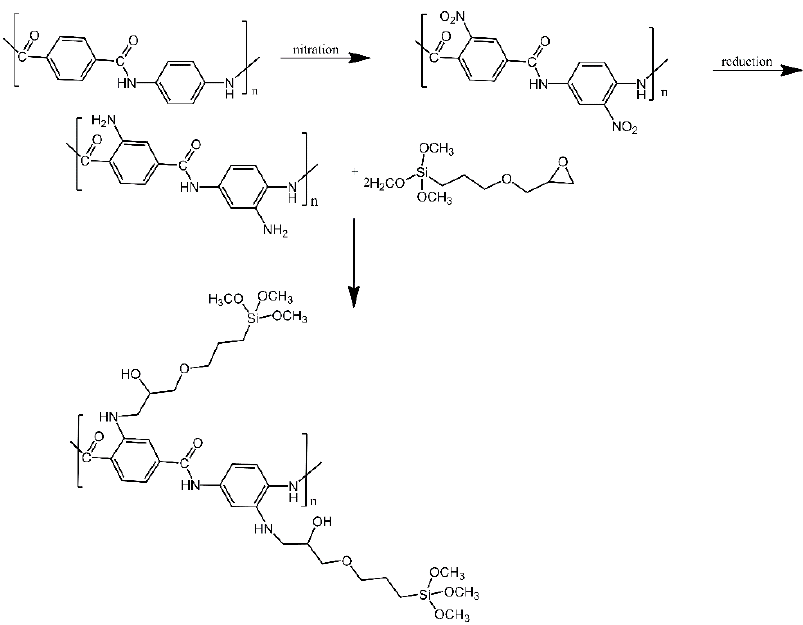
Figure 7. Mechanism for preparation of g-(amino groups aramid fibre). Based on Ref. [15].